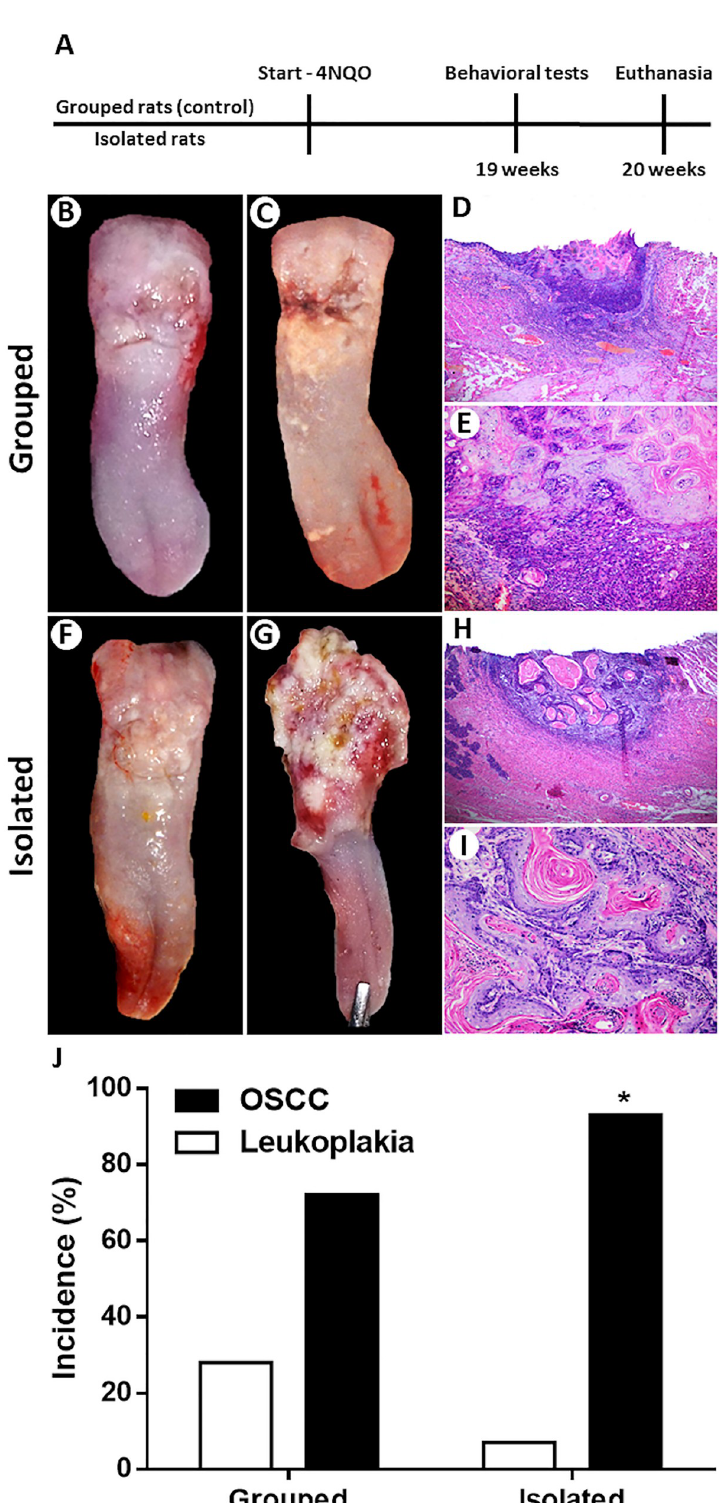
Fig 1. Experimental design (A) . Clinicopathological characteristics of the OSCCs from grouped rats (B-E) . White plates with a small ulcer (B) . Yellowish white plaques with an infiltrative ulcer (C) . Small-size OSCC (H&E; 50x) (D)